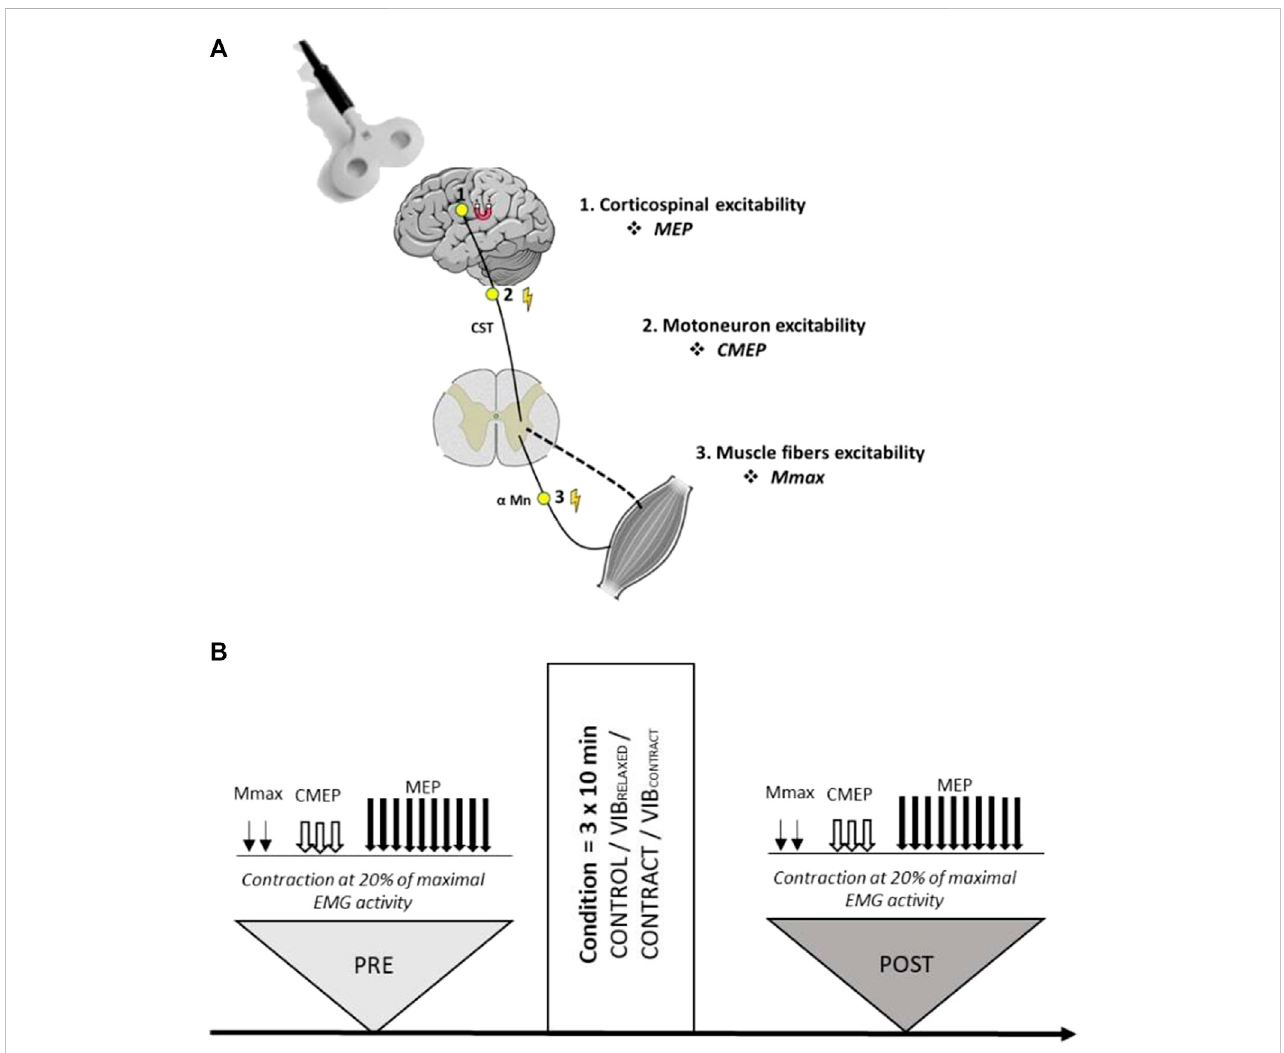
FIGURE 1 (A) Sitesofstimulationsforeachevokedresponse. (B) Overviewoftheexperimentaldesign.TwoMmax,threeCMEPsandtenMEPswereevokedduringa low-level contraction of the fl exor carpi radialis muscle. All measurements were performed with the same order before (PRE) and after (POST) the control, vibration (VIB RELAXED ), contraction (CONTRACT) or vibration + contraction (VIB CONTRACT )